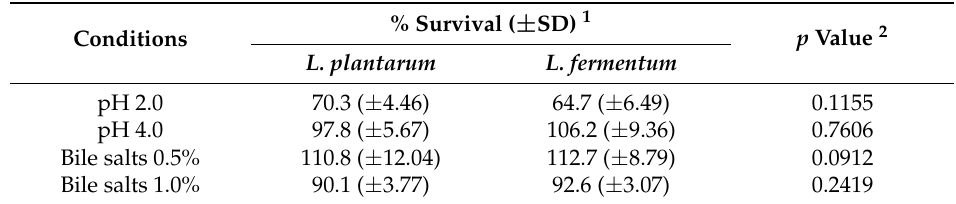
Table 5. Survival of L. plantarum ATCC 8014 and L. fermentum ATCC 23271 in the presence of acidic pH and bile